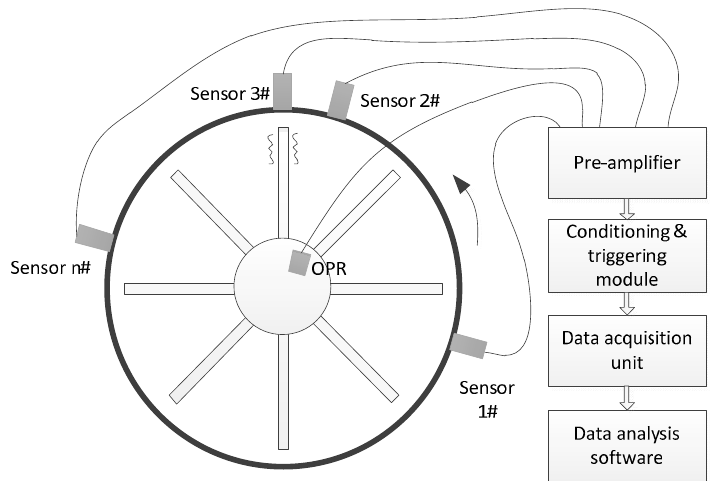
Figure 1. The block diagram of a blade tip timing (BTT) system.